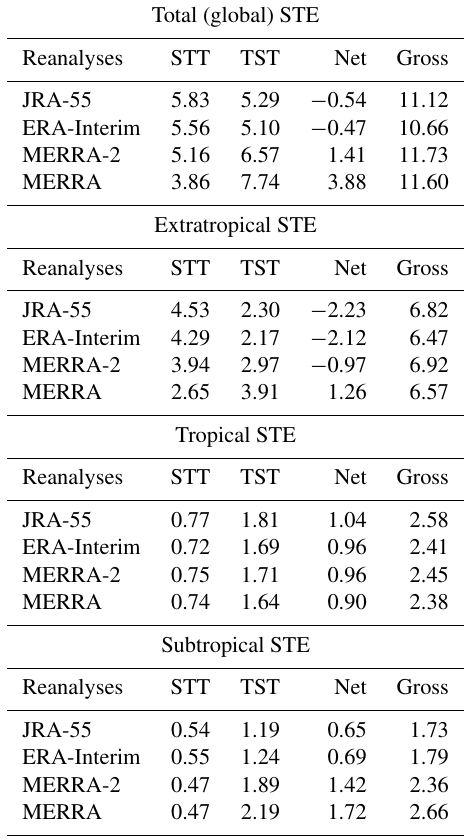
Table 1. Globally integrated and annually averaged STE mass fluxes for each reanalysis model. STT, TST, net (TST minus STT), and gross (TST plus STT) mass fluxes are given for each transport region (i.e., total/global, extratropical, tropical, and subtropical). All mass flux units are 10 10 kgs − 1 .